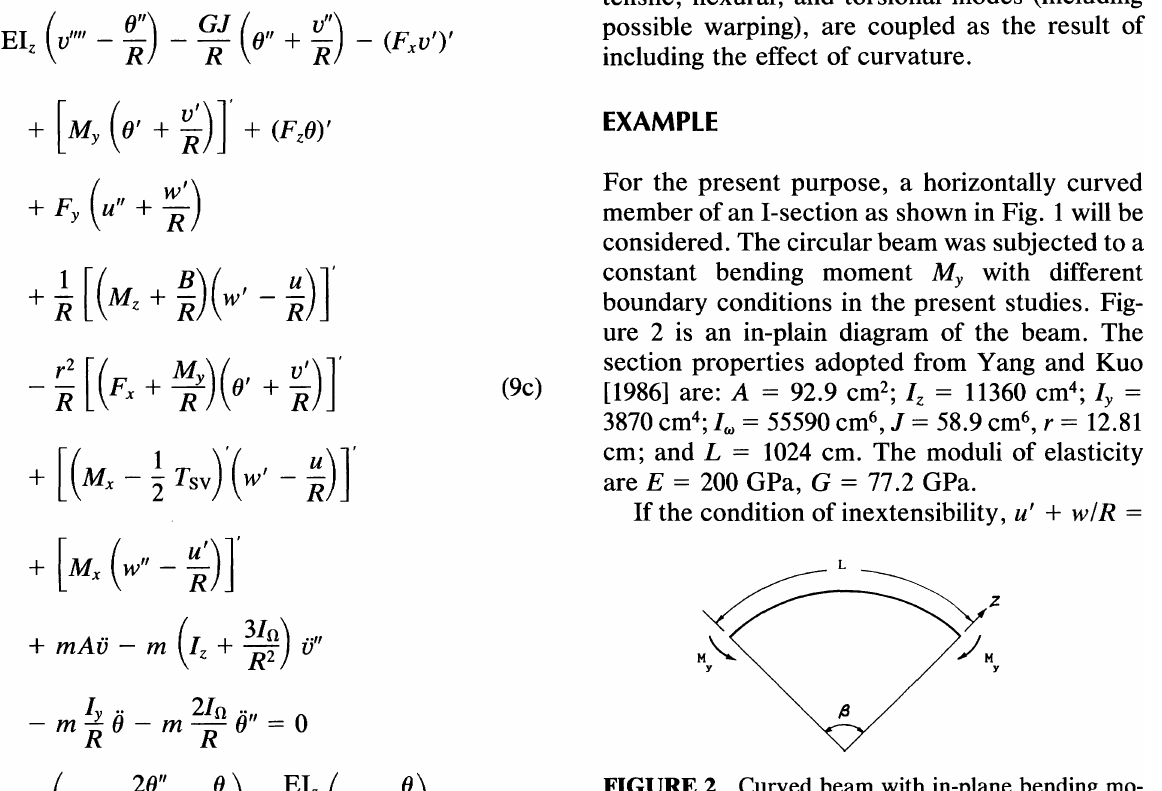
FIGURE 2 Curved beam with in-plane bending mo